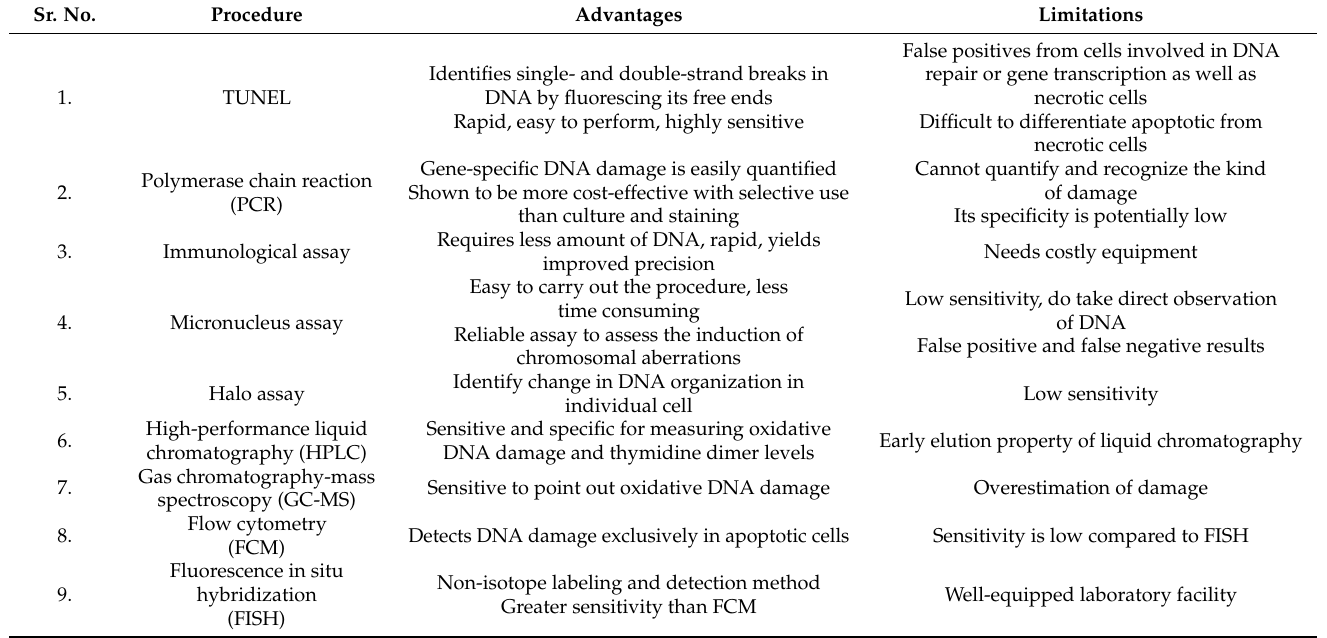
Table 1. DNA damage assessment